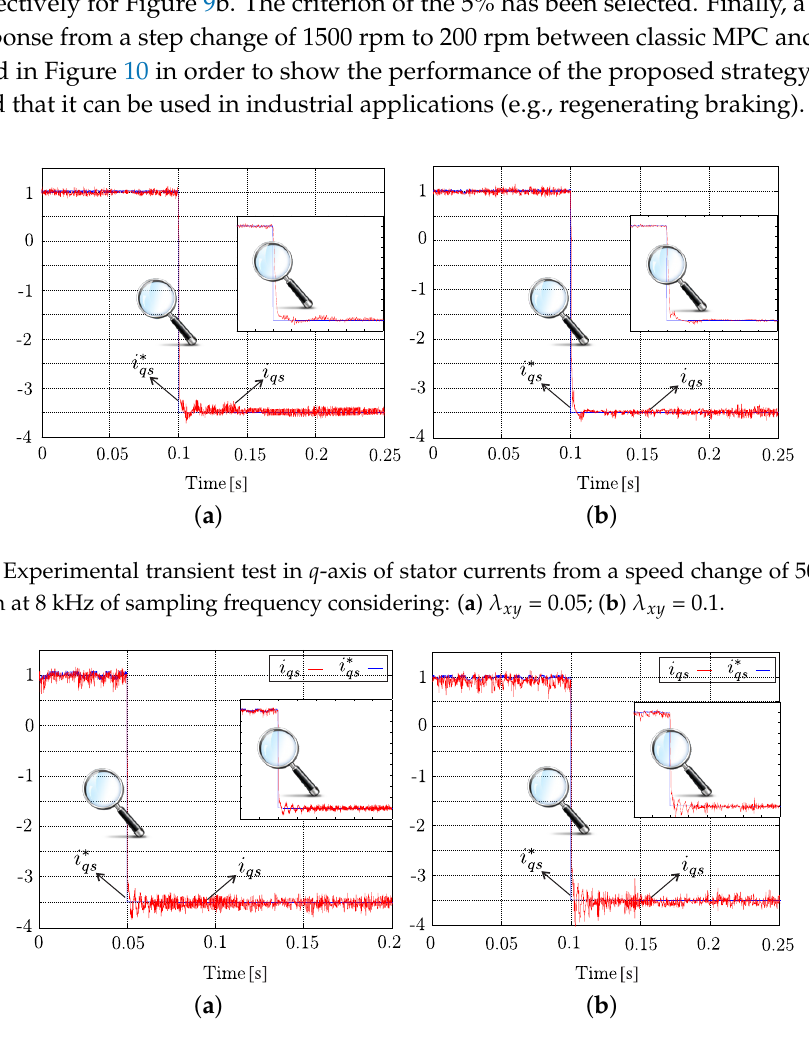
Figure 10. Experimental transient test in q -axis of stator currents from a speed change of 1500 rpm to 200 rpm at 16 kHz and 8 kHz of sampling frequency, respectively: ( a ) Classic MPC; ( b )